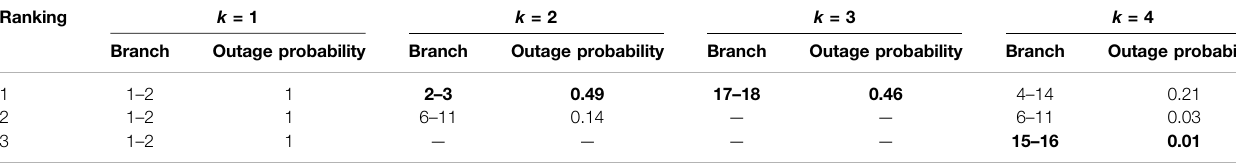
TABLE 2 | Branch outage probability ranking with the control actions obtained by Model 2.